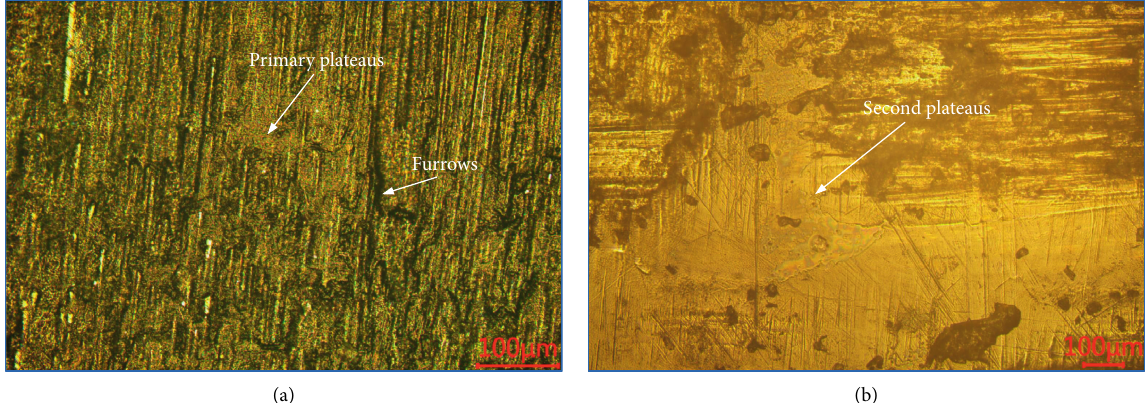
Figure 11: Microscopic morphologies of composites (a) T300/BS-4 and (b) aramid/4211 coupled with brass sliding blocks under a 100N